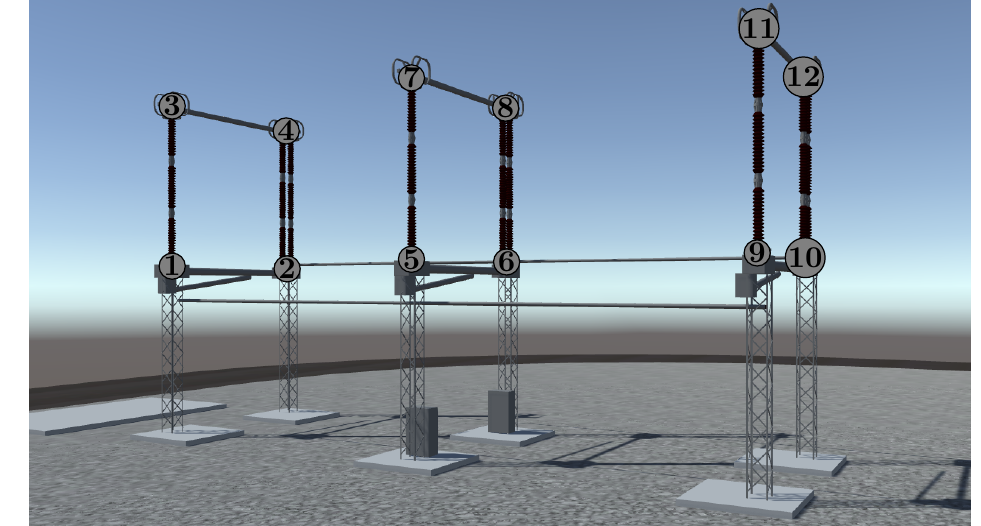
Figure 12. Power disconnector keypoints